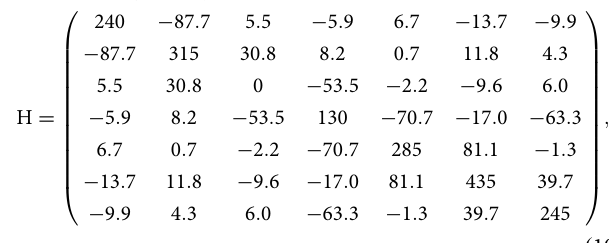
where the site energies have been shifted to set the energy of the fi nal receptor site (the reaction centre of the FMO complex) to 0. The units are cm − 1 (wavenumber), used commonly in spectro- scopy as a unit of energy when multiplied by hc (the product of Planck ’ s constant and the speed of light).